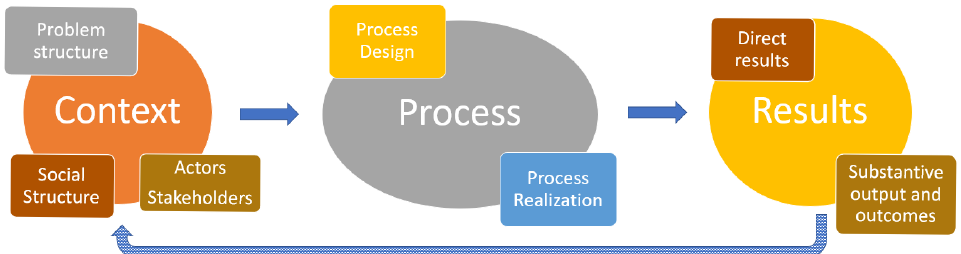
Figure 1. Analytical framework of public participation effectiveness [9].